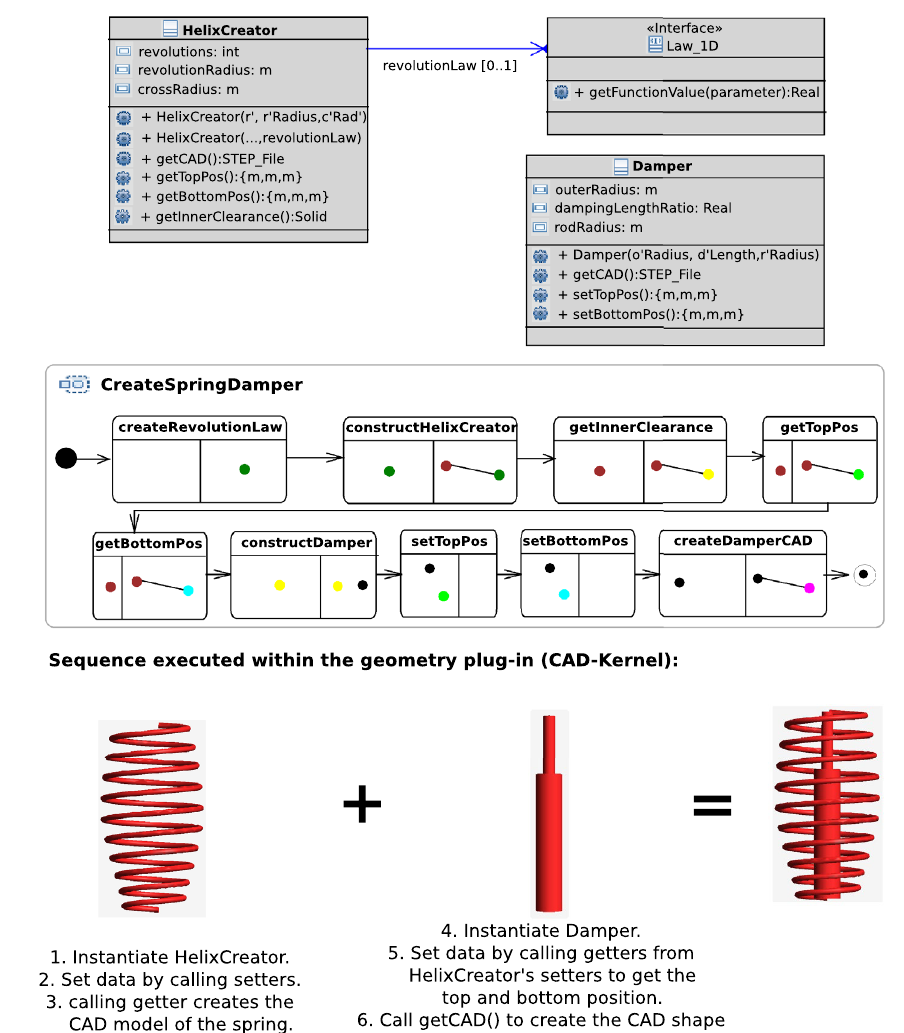
Fig. 15 a hierarchical composition of the car’s development